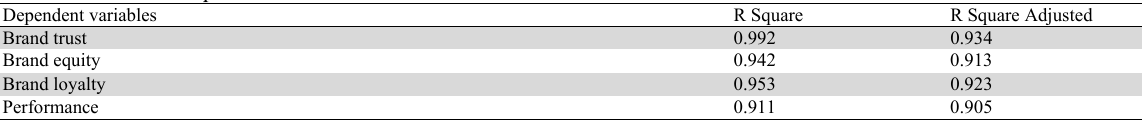
The results of the R-Square Dependent